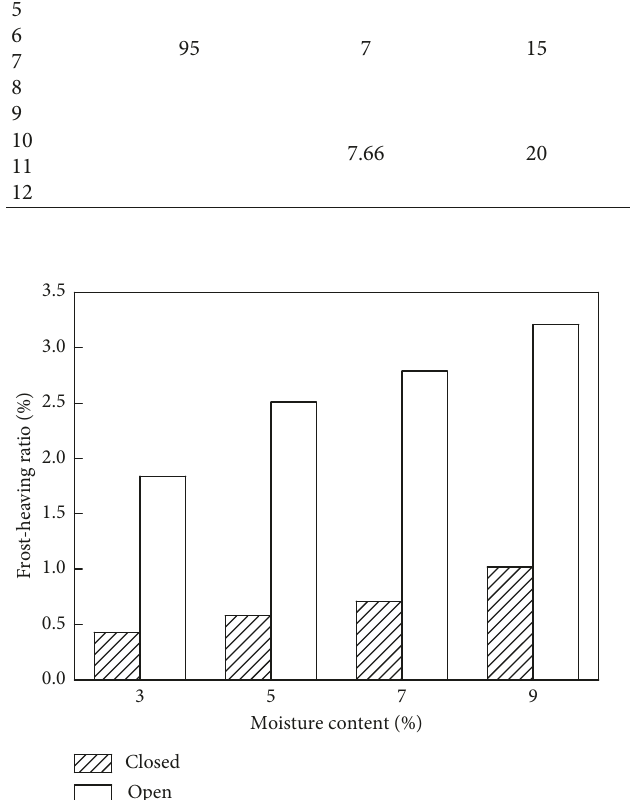
Figure 7: Relationship between water replenishing and frost- heaving ratio.